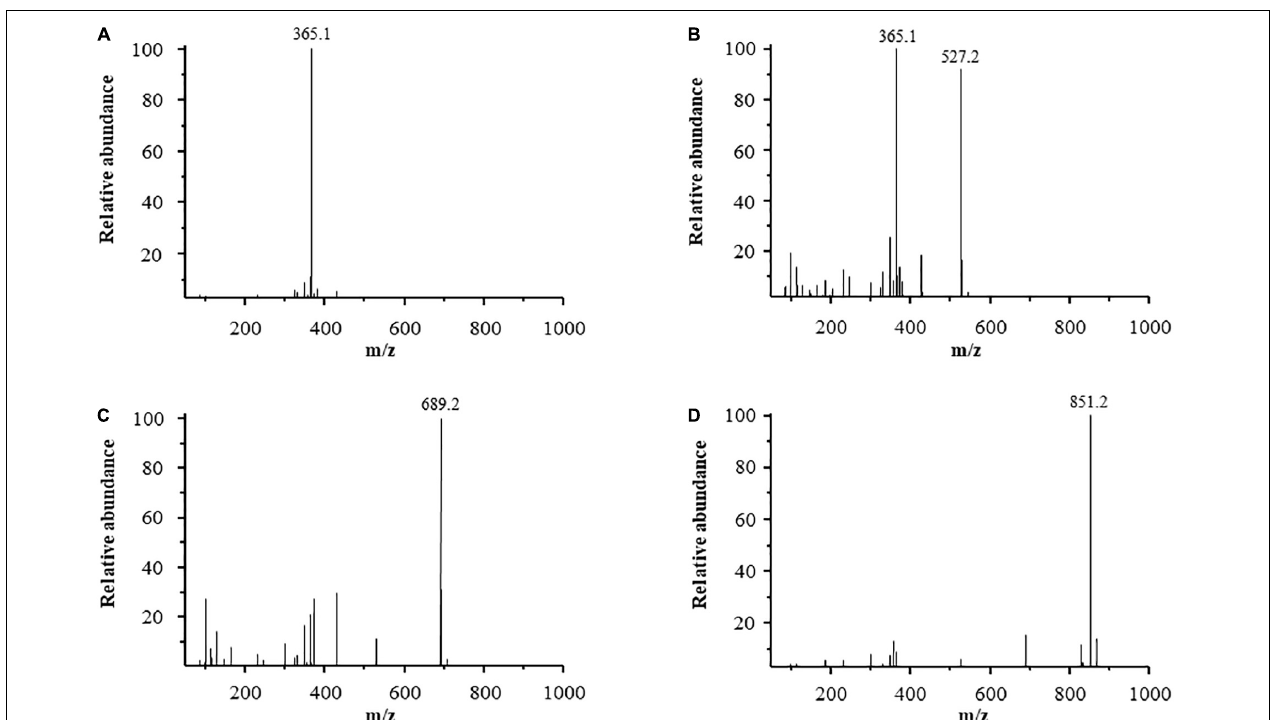
FIGURE 2 | ESI-MS of purified LOS, (A) laminaribiose, (B) laminaritriose, (C) laminaritetrose, (D) laminaripentaose.